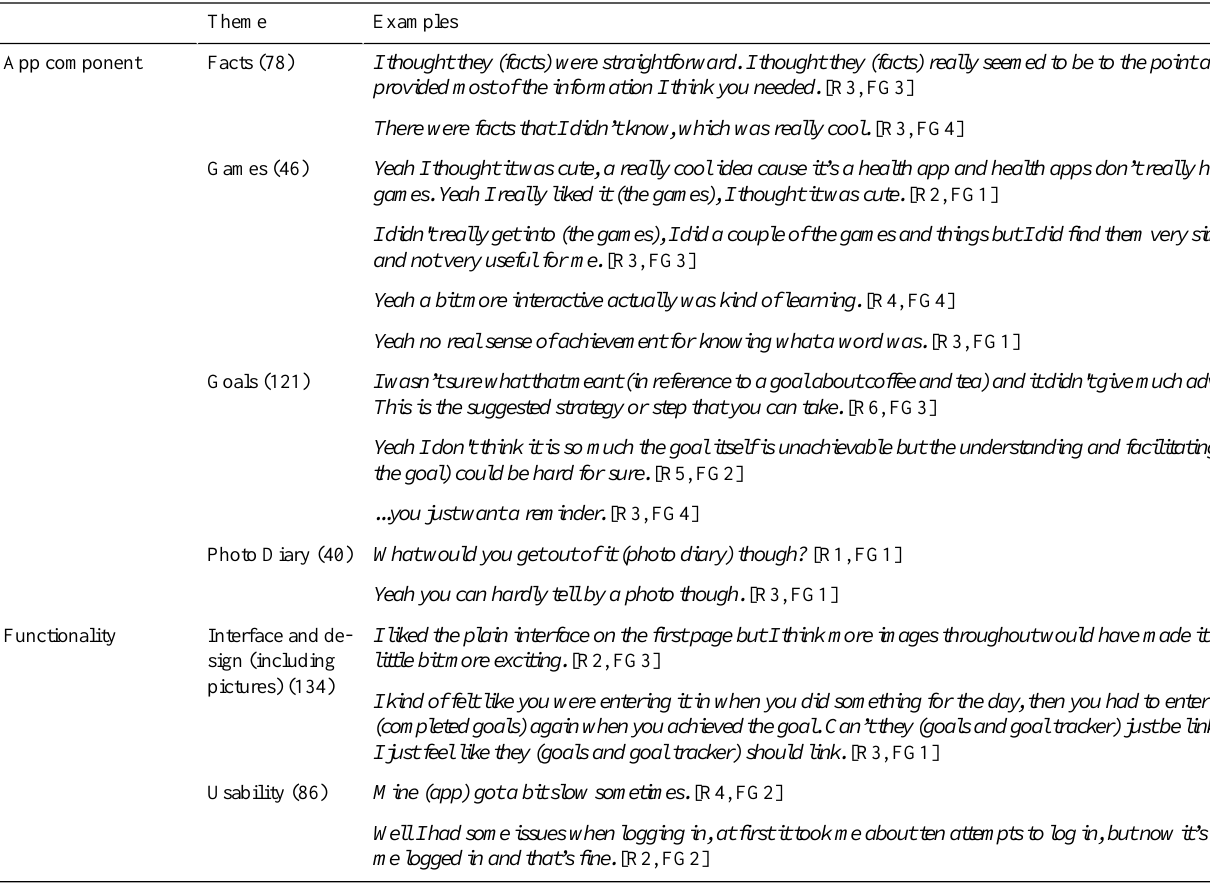
Table 1. Themes and their frequency of occurrence (represented in parentheses). Quotes presented in intelligent